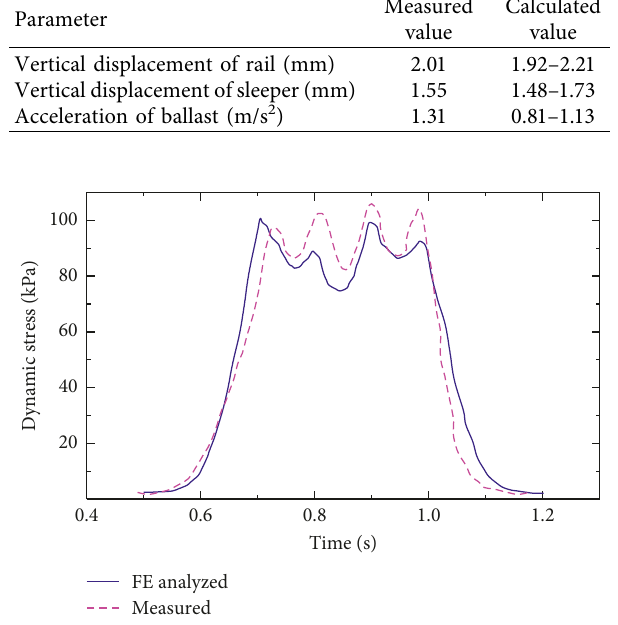
Figure 8: Measured and calculated subgrade surface dynamic